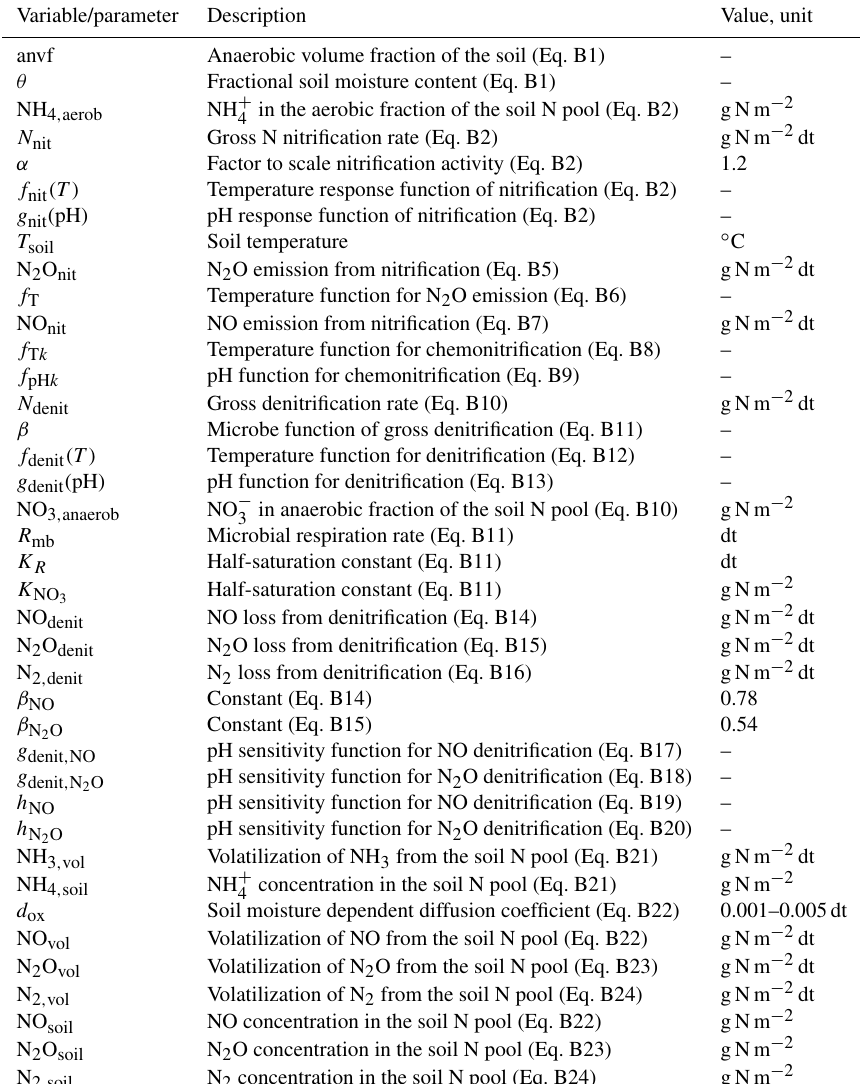
Table B1. List of variables and parameters used in nitrogen (N) loss algorithm NL1. NH + NO − : nitrate; NH 3 : ammonia; N 2 : dinitrogen; dt: time 3